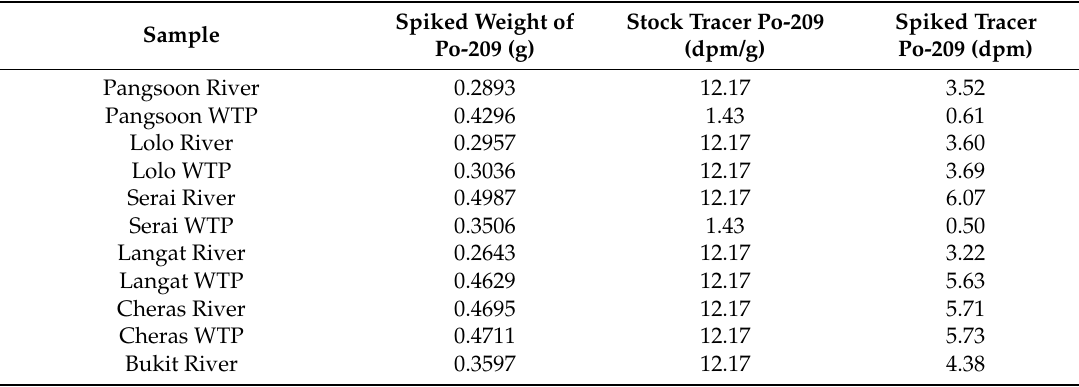
Table 1. Amount of Spiked Po-209 Tracer.